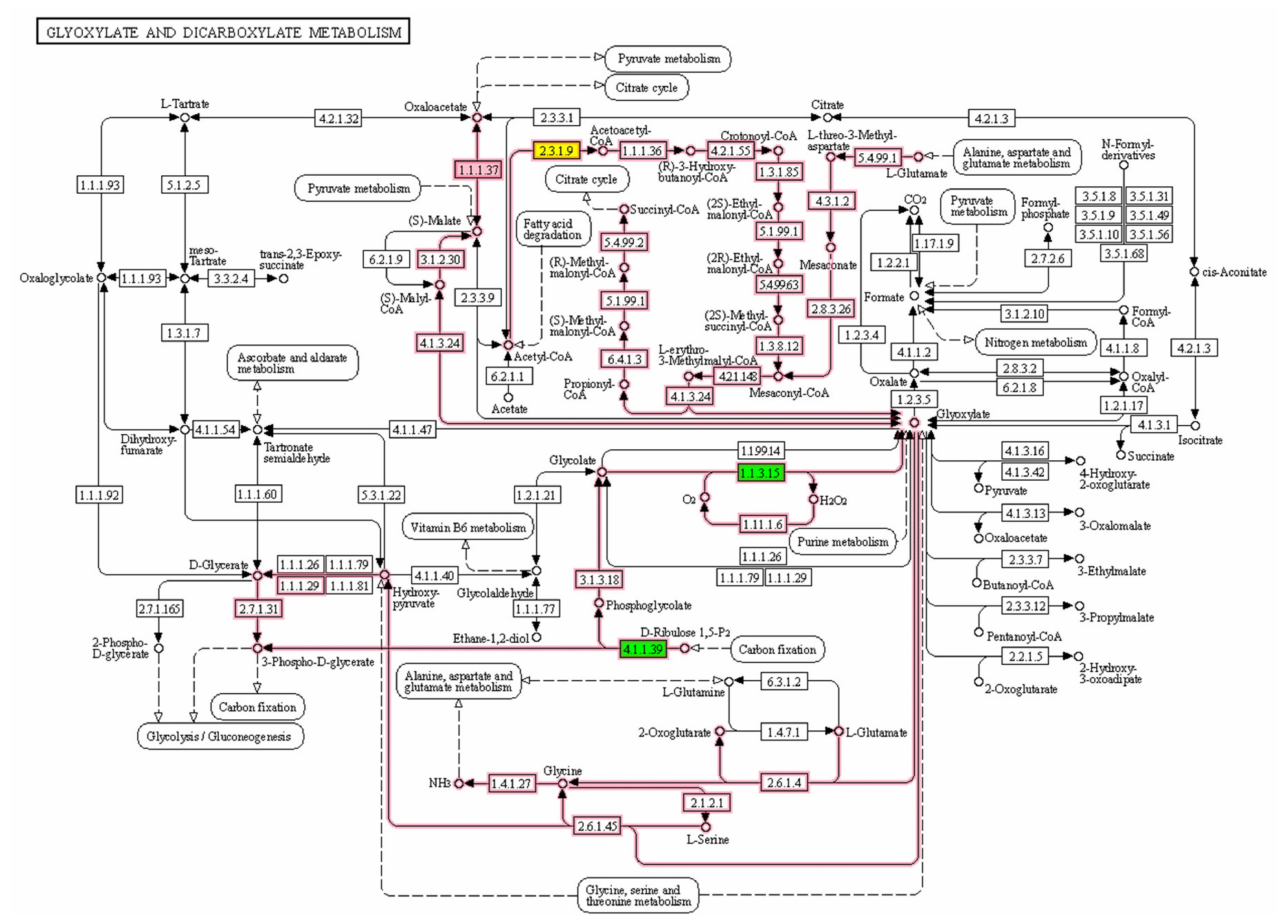
Figure 8. KEGG map for metabolic pathways of glyoxylate and dicarboxylate metabolism. Malate dehydrogenase (EC:1.1.1.37; PMDH2) is associated to methylaspartate cycle and is colored in pink; thiolase family protein (EC:2.3.1.9; AACT1) are signed in yellow and is associated to ethylmalonyl pathway of terpenoid synthesis; and proteins (S)-2-hydroxy-acid oxidase GLO1 (EC:1.1.3.15; Q9LRR9) and ribulose bisphosphate carboxylase small chain 1A (EC:4.1.1.39; P10795) are associated to pho- torespiration and are marked in